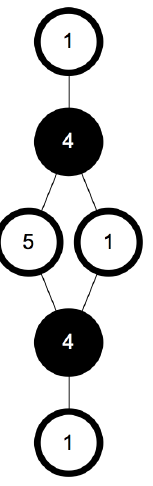
Figure 17 . Adynkra Diagram for 5D (1 , 0) Multiplet.